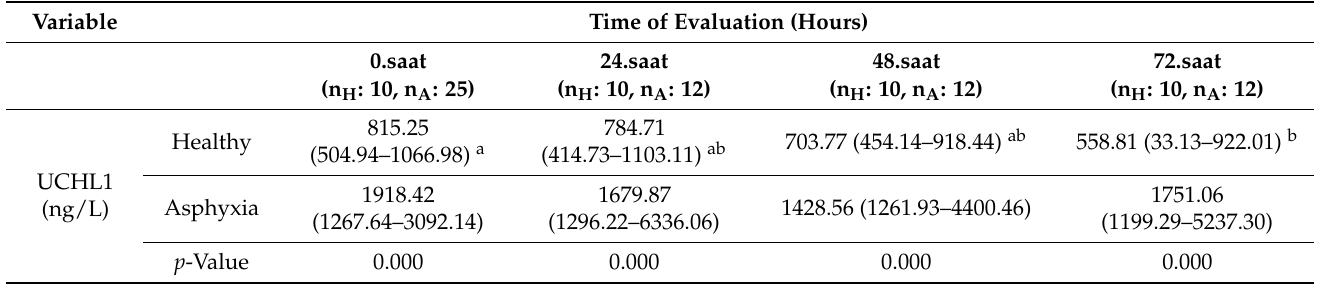
Table 4. Biomarker concentrations result in healthy and calves with perinatal